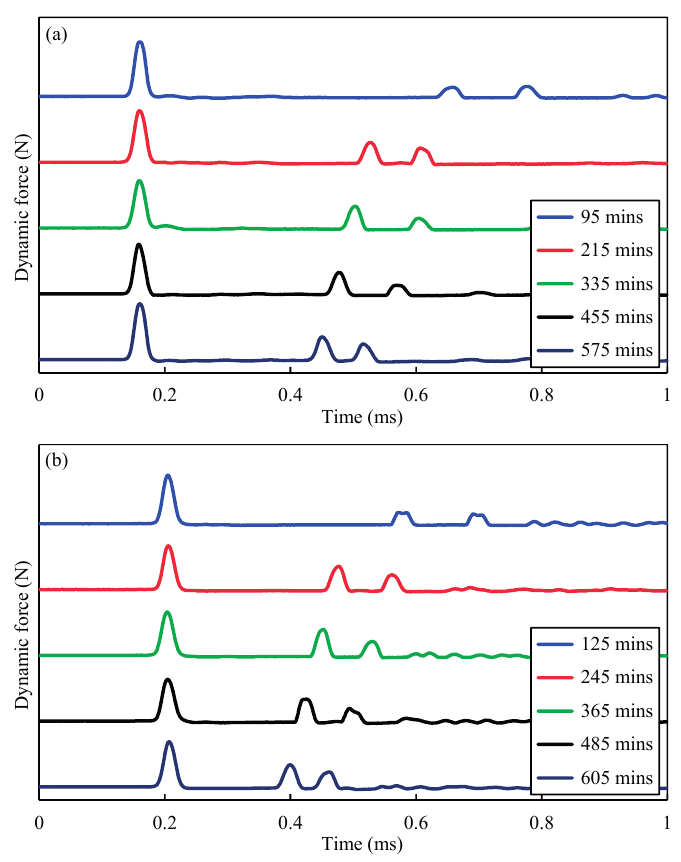
Figure 5. Force profile of the HNSWs waveforms recorded at different ages of concrete. Measurements taken at the ( a ) 11th bead and ( b ) 16th